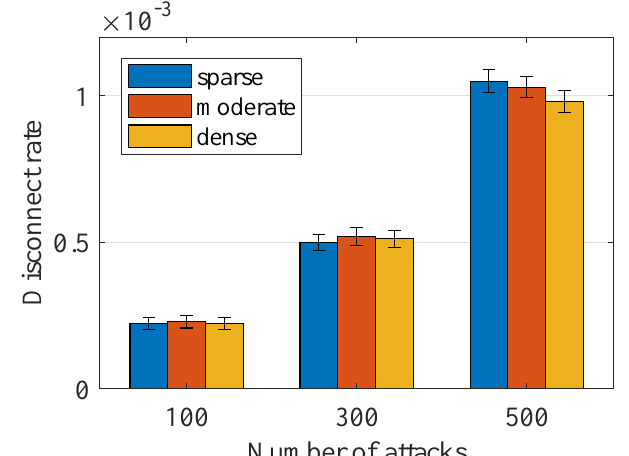
Figure 10. Performance under MITM attack.